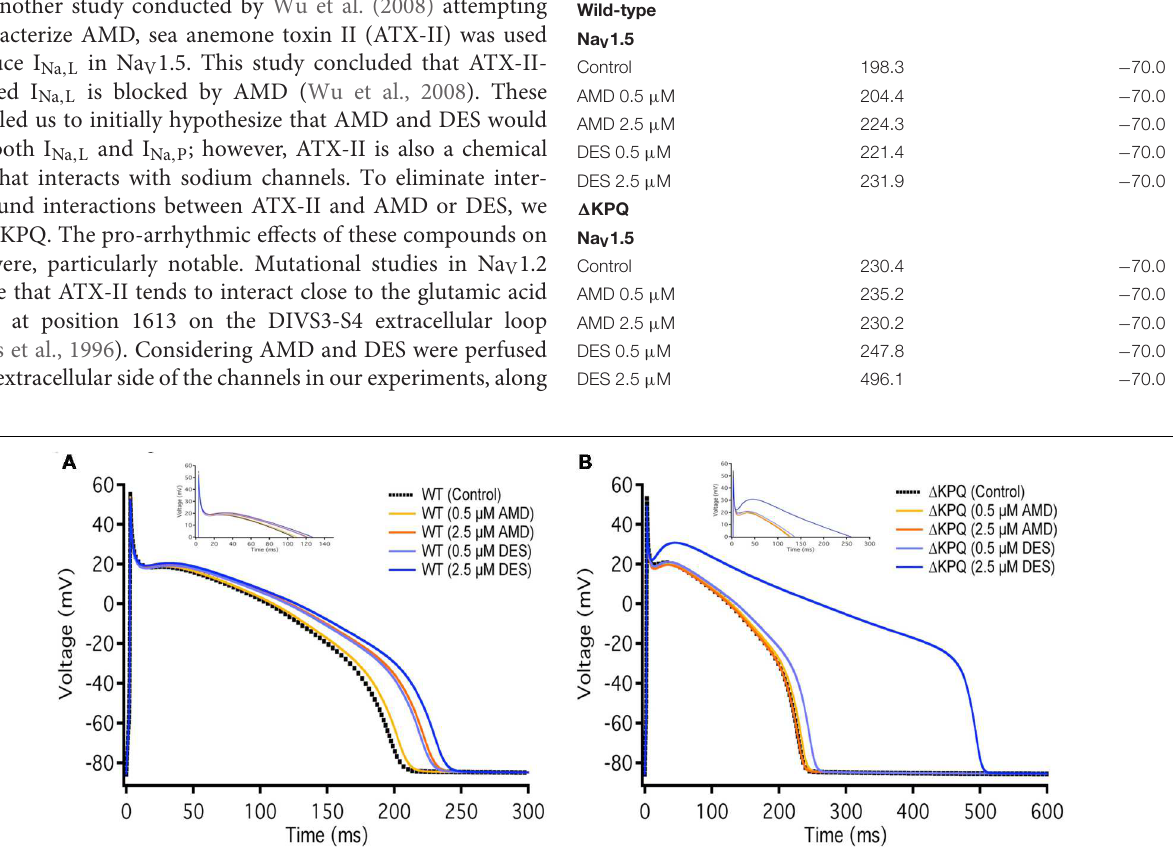
Frontiers in Pharmacology |